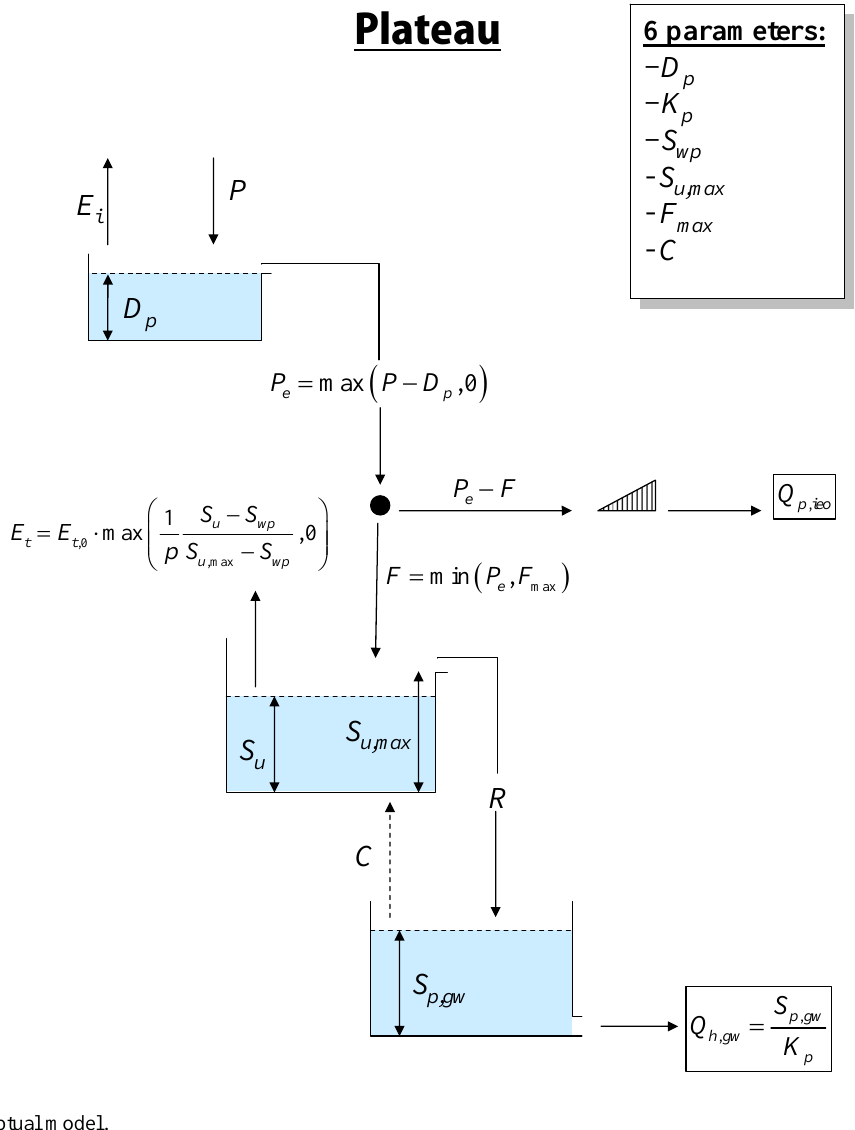
Fig. 4. Plateau conceptual